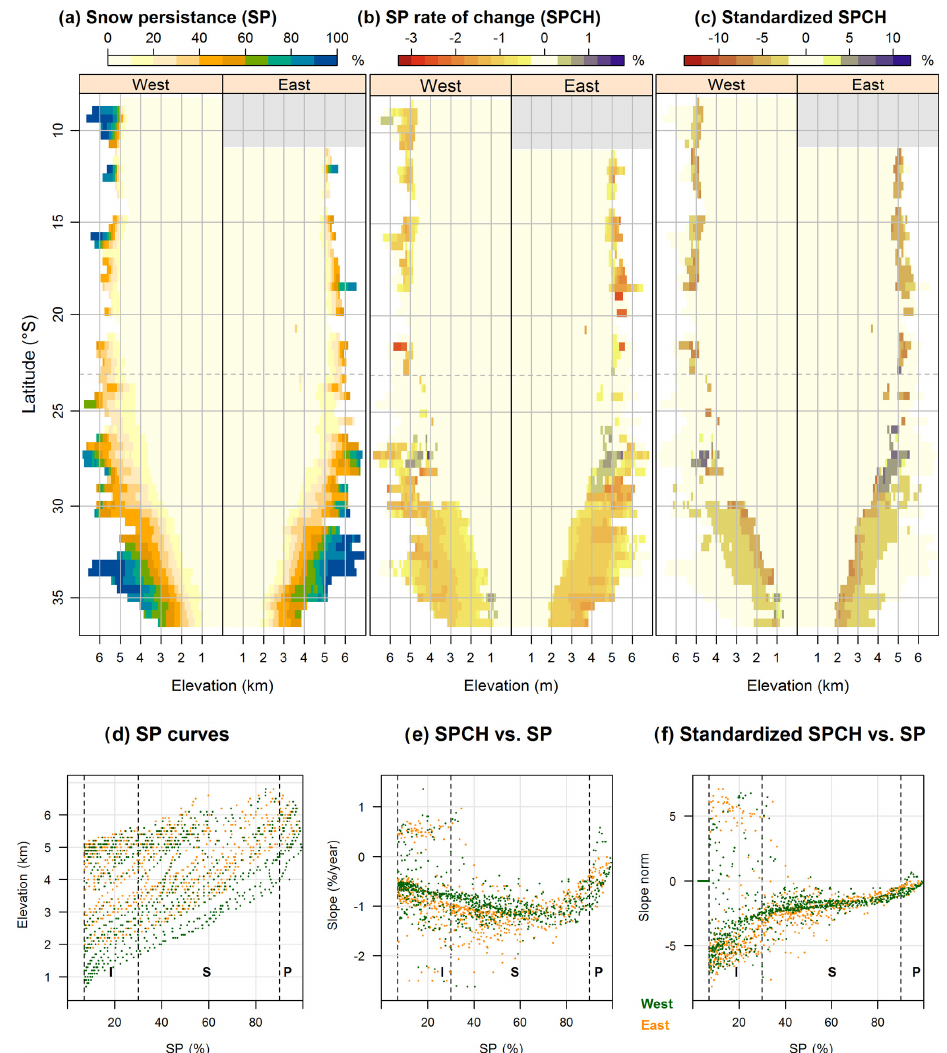
Figure 4. Latitude–elevation band analysis by side of the continental divide (west–east) for (a) mean annual SP, (b) rate of change (Theil–Sen slope) from the Mann–Kendall trend test for annual SP, and (c) standardized rate of change from 2000 to 2016; only areas with significant trends ( p ≤ 0.05) and SP ≥ 7% are colored. Gray areas in panels (a, b, c) , represent latitudes masked due to high frequency of cloud cover in snow-covered area analysis ( > 30% time period). The SP curves in plot (d) show the relation of SP with elevation. The relation between SP and Theil–Sen slope is shown in plot (e) , and standardized Theil–Sen slope in plot (f) . West (green) and east (orange) sides are plotted in panels (d, e, f) ; vertical dashed gray lines represent thresholds for intermittent (I), seasonal (S), and persistent (P) snow zones (Saavedra et al.,